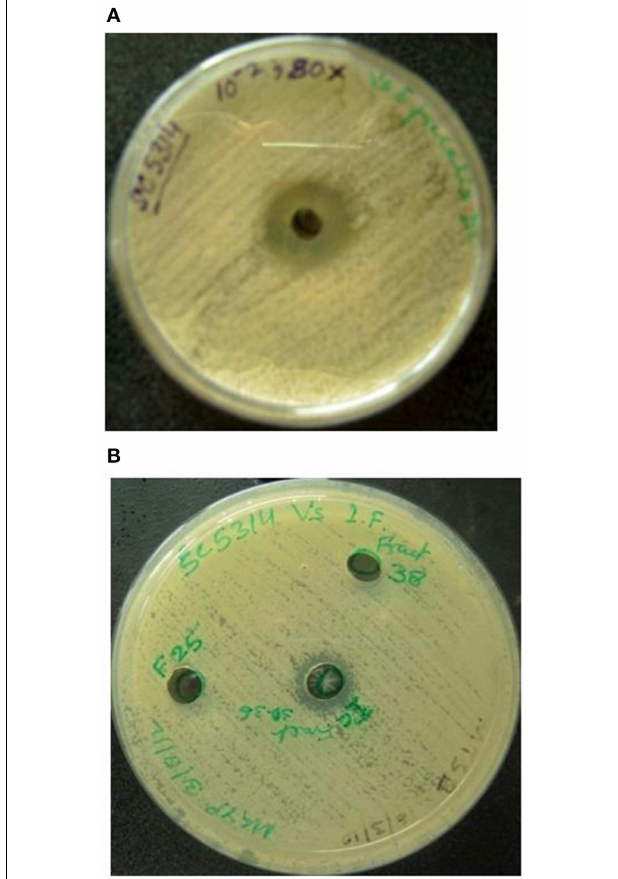
FIGURE 1 | (A) Dialyzed concentrate (after ammonium sulfate fractionation and dialysis) shows clear zone of inhibition against C. albicans SC 5314. F25 and F38 denote ion-exchange fractions showing no inhibition. (B) Anti -Candida activity of pooled (30–36) fractions (collected